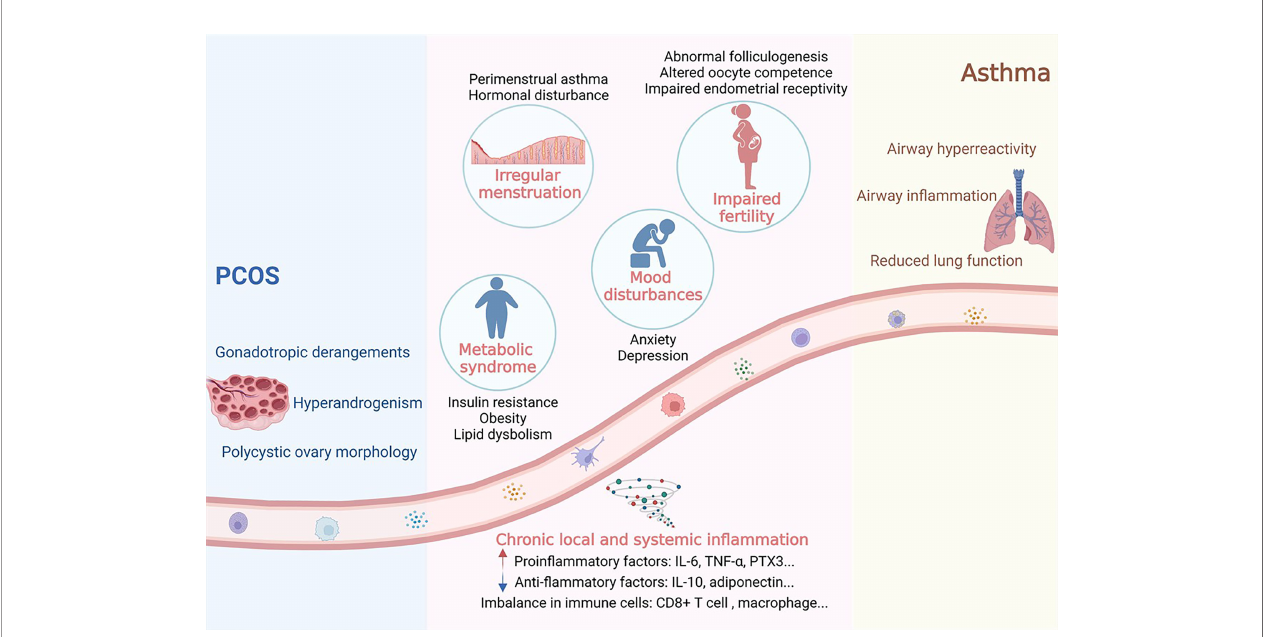
FIGURE 1 | Potential associations between PCOS and asthma. Women with PCOS or asthma are characterized by several common disease phenotypes, including metabolic syndrome, irregular menstruation, impaired fertility and mood disturbances. And chronic local and systemic in fl ammation may act as one of the common molecular mechanisms behind these phenomena. Image was created with Biorender ®